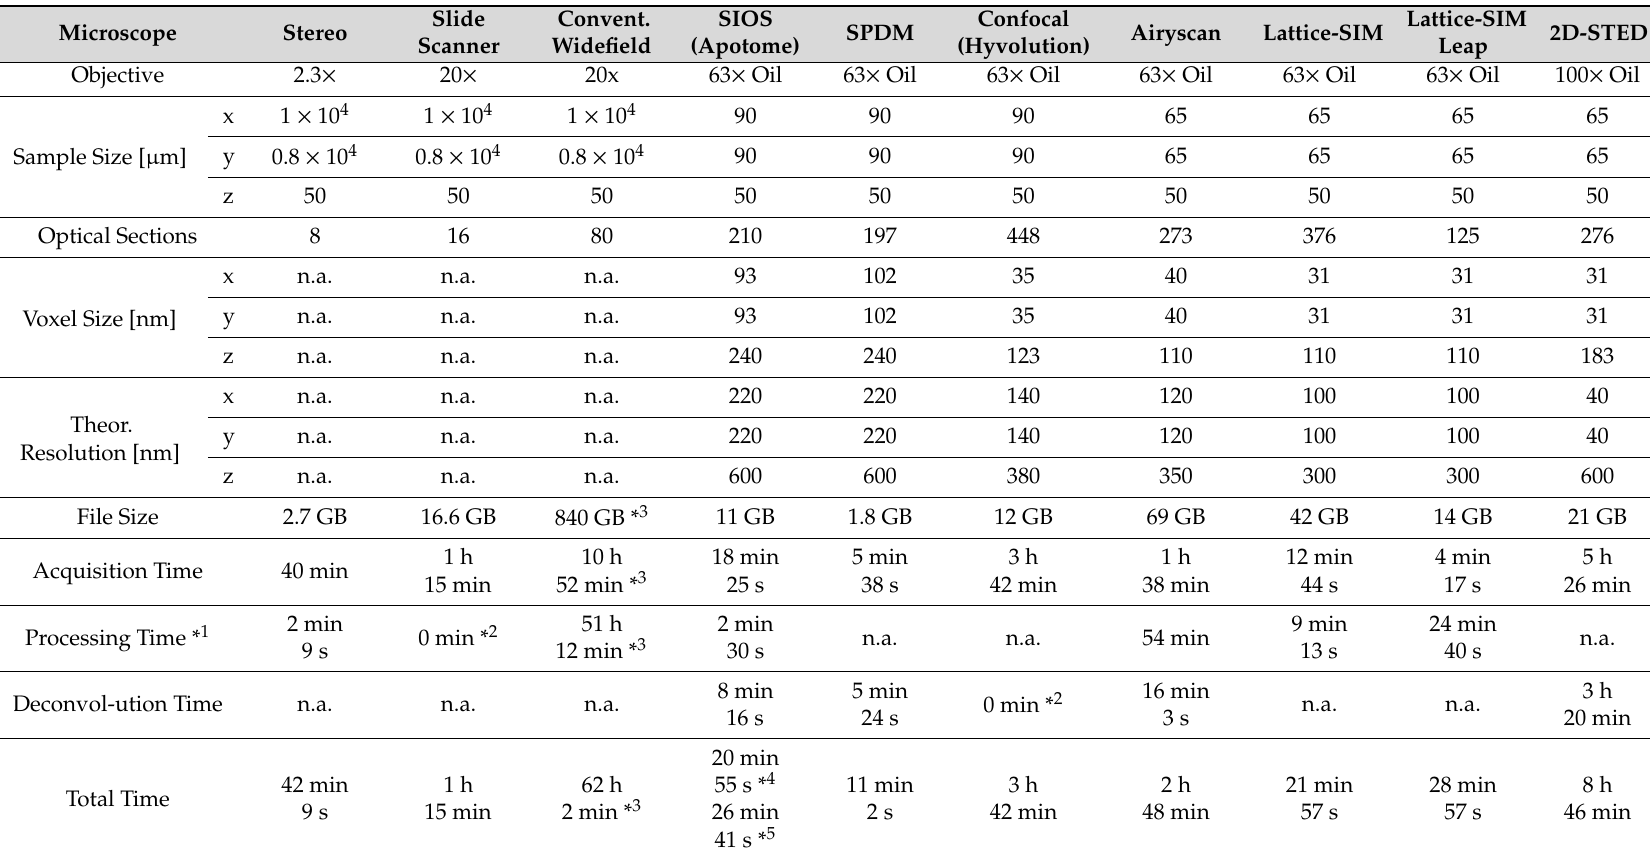
Table 1. Comparison of di ff erent microscopy platforms used to image the same specimen.